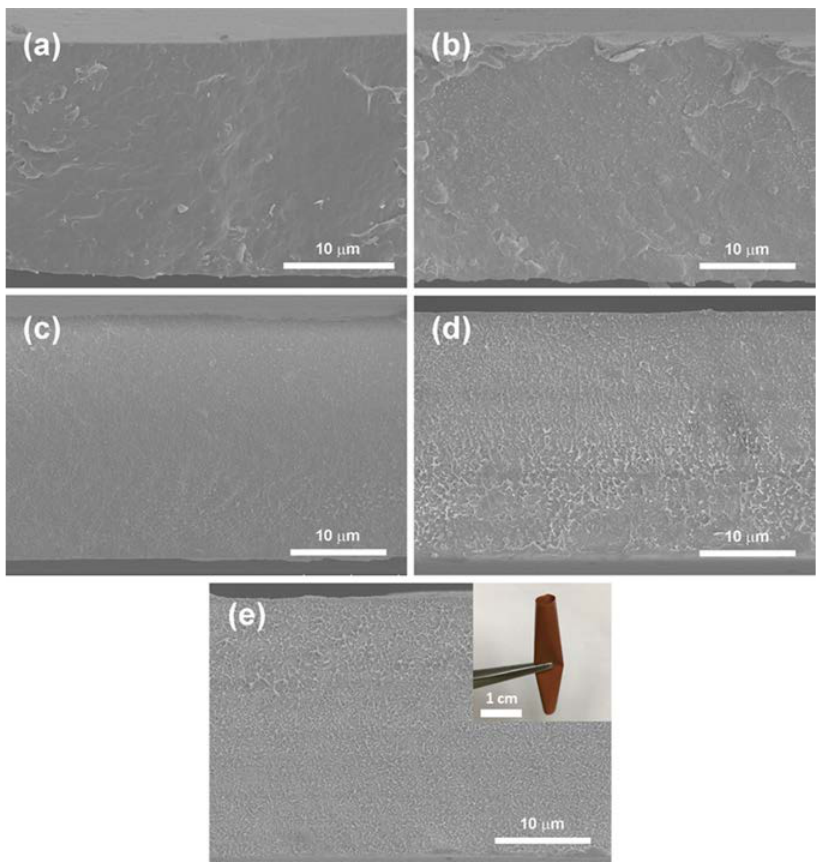
Figure 4. SEM images of cross-sectional film of: ( a ) pristine P(VDF-HFP), ( b ) 5 vol%, ( c ) 10 vol%, ( d ) 15 vol%, and ( e ) 20 vol% composites. Inset is the digital photograph of 20 vol% film.